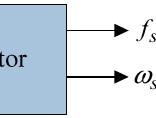
Figure 3. The input-output relationship of the algorithm.